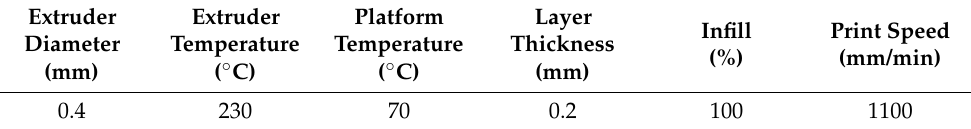
Table 2. MEX parameters used for printing all lattice structure and dog-bone samples with TPU